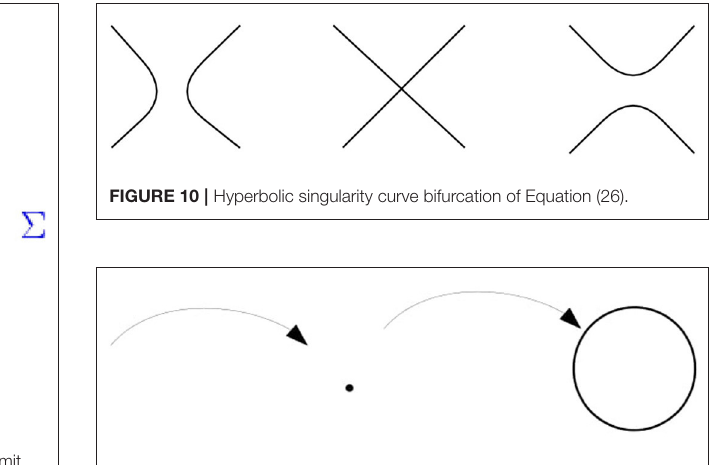
FIGURE 11 | Elliptic singularity curve bifurcation of Equation (26).